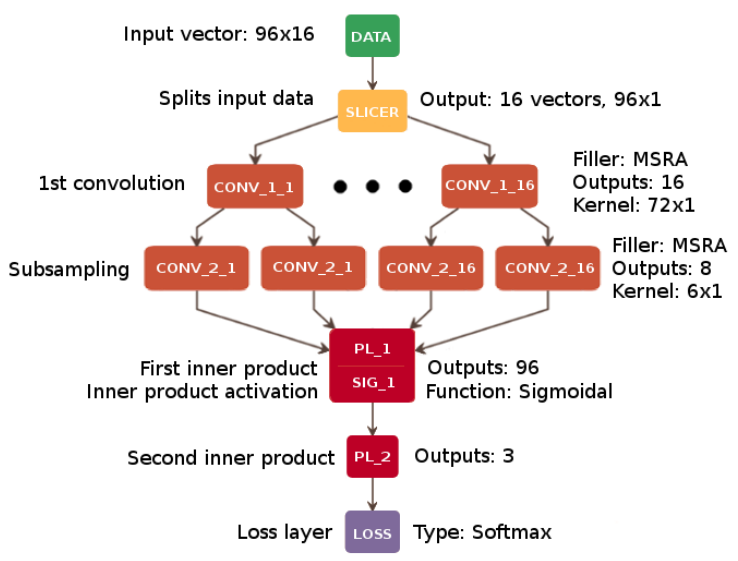
Figure 5. The adaptation of Cecotti’s multi-channel network architecture to our